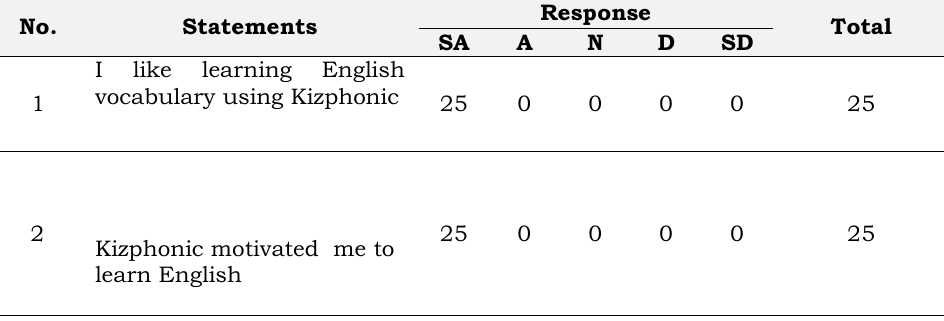
Table 2. Responses of the Questionnaire